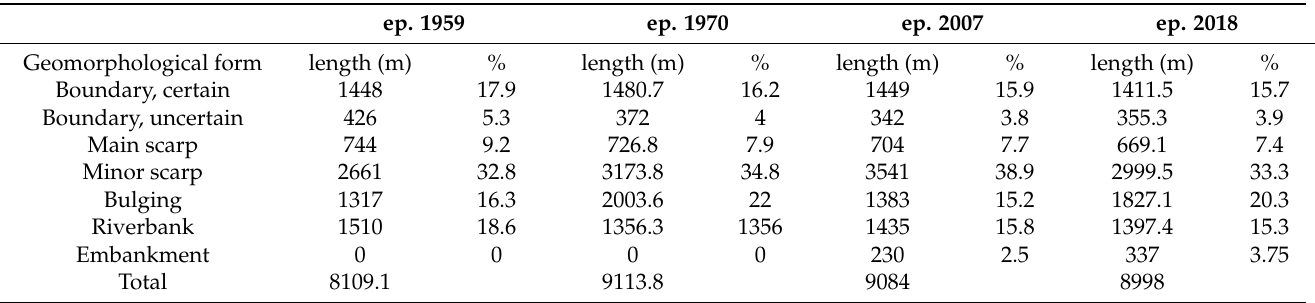
Table 3. Statistical presentation of isolated geomorphological forms for four time epochs based